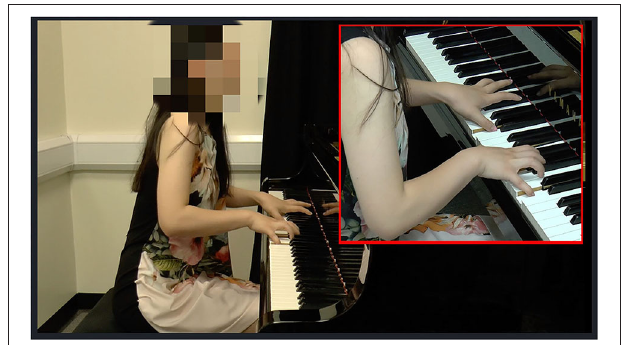
FIGURE 3 | The video presentation with two camera